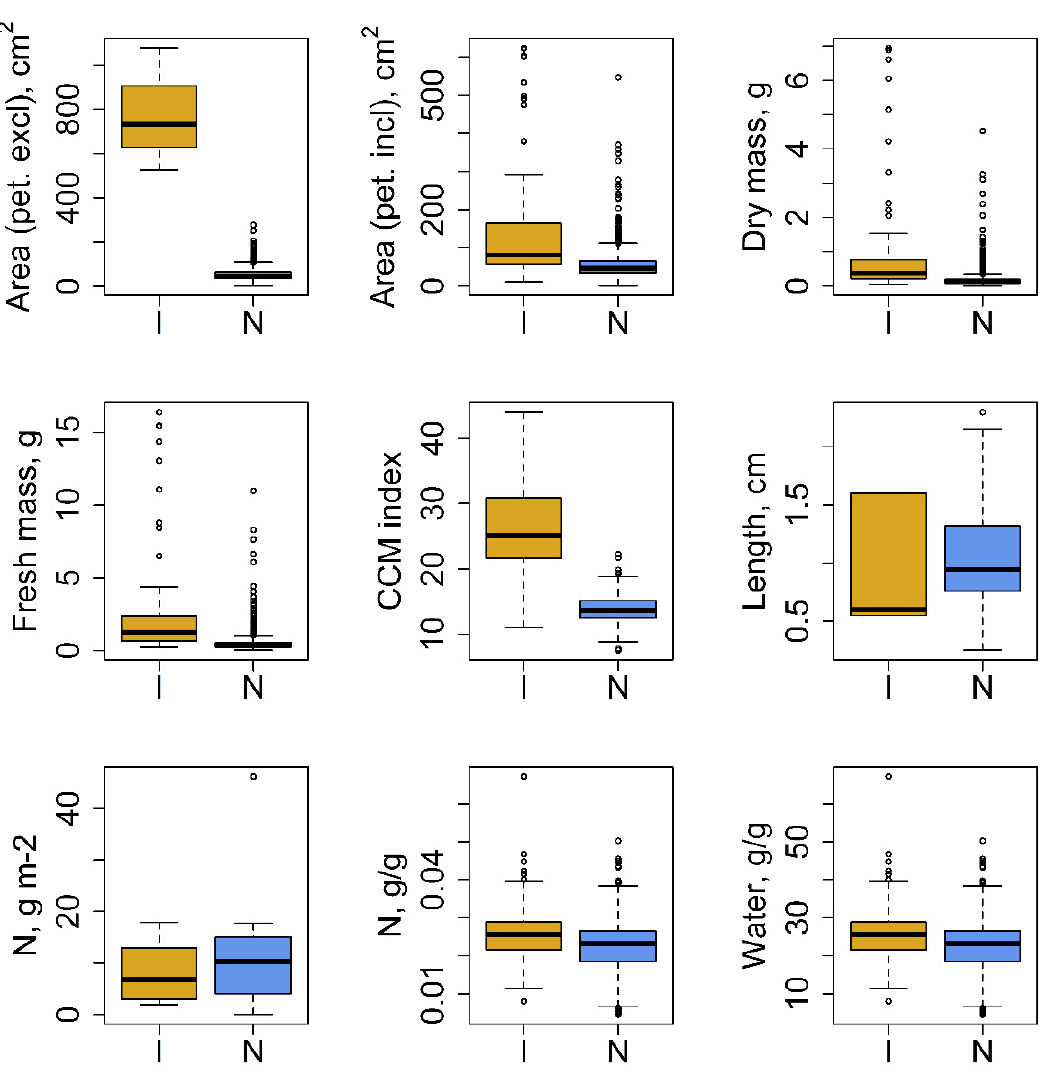
Figure 1. Leaf trait data compared between native (N) and introduced (I) host plants of Lycorma delicatula. The trait names are as follows (from left to right, and from top to bottom): Leaf area (in case of compound leaves: leaf, petiole excluded); Leaf area (in case of compound leaves: leaf, petiole included); Leaf dry mass (single leaf); Leaf fresh mass; Leaf chlorophyll content per leaf area (CCM index); Leaf length; Leaf nitrogen (N) content per leaf (g m − 2 ); Leaf nitrogen (N) content per leaf dry mass (g/g); and Leaf water content per leaf dry mass (not saturated). Boxplots represent the median (thick horizontal line), the 25th and 75th percentiles (the box), the 5th and 95th percentiles (the whiskers). Leaf area (petiole excluded) and leaf chlorophyll content per leaf area (CCM index) only were significantly higher in introduced plants that those in native plants (LMM, fixed effects: p adj < 0.0001 and p adj = 0.0009, respectively). All other pairwise comparisons were not significant different at α =